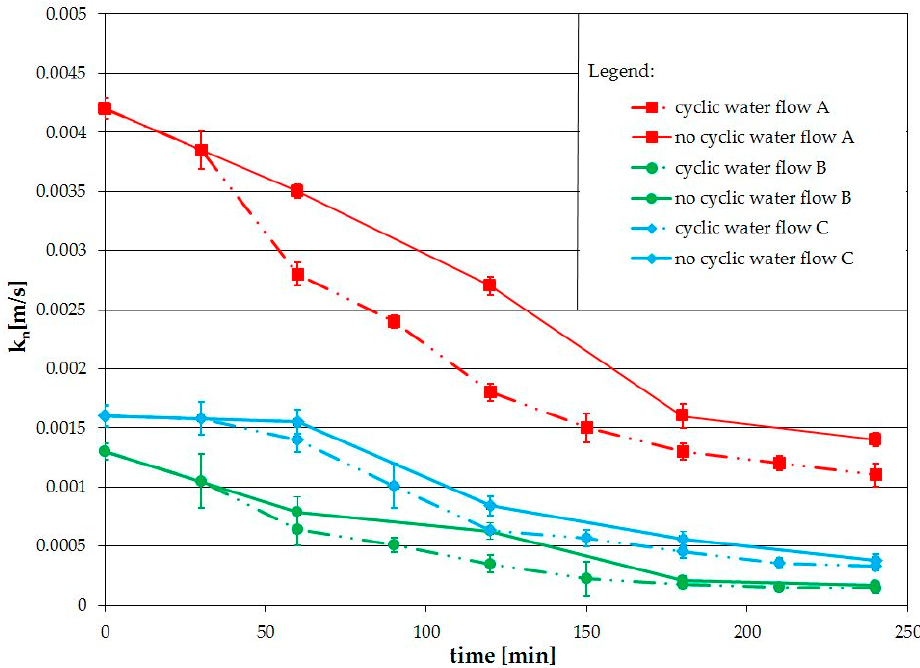
Figure 12. Decreasing of water permeability coefficients with time.